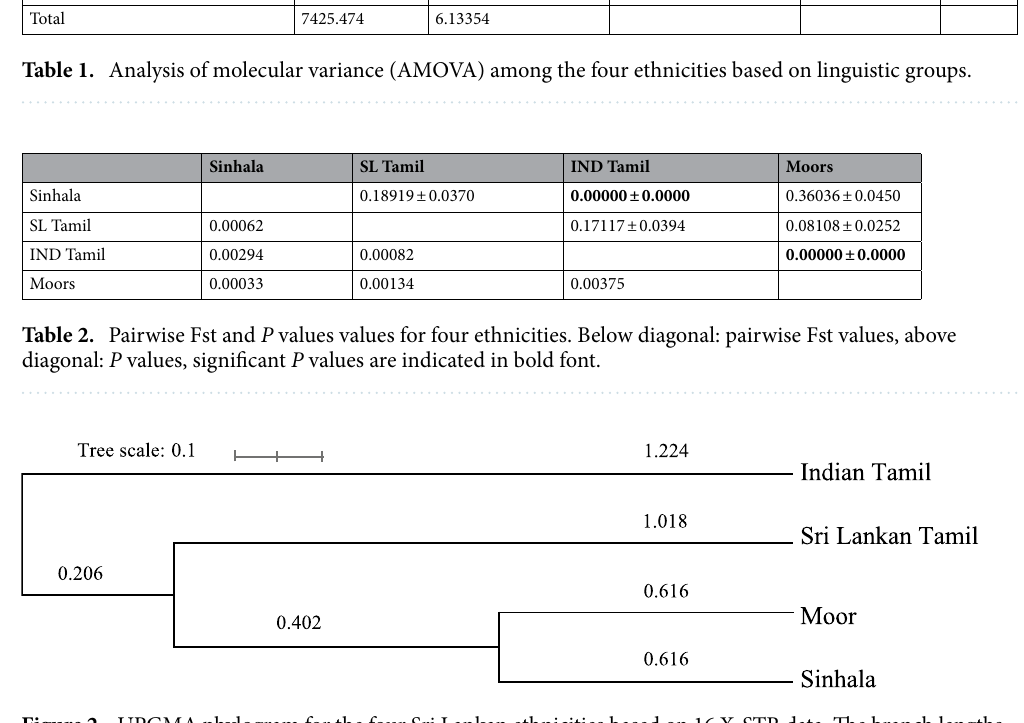
Figure 2. UPGMA phylogram for the four Sri Lankan ethnicities based on 16 X-STR data. The branch lengths are in the same units as those of the evolutionary distances used to infer the phylogenetic tree.